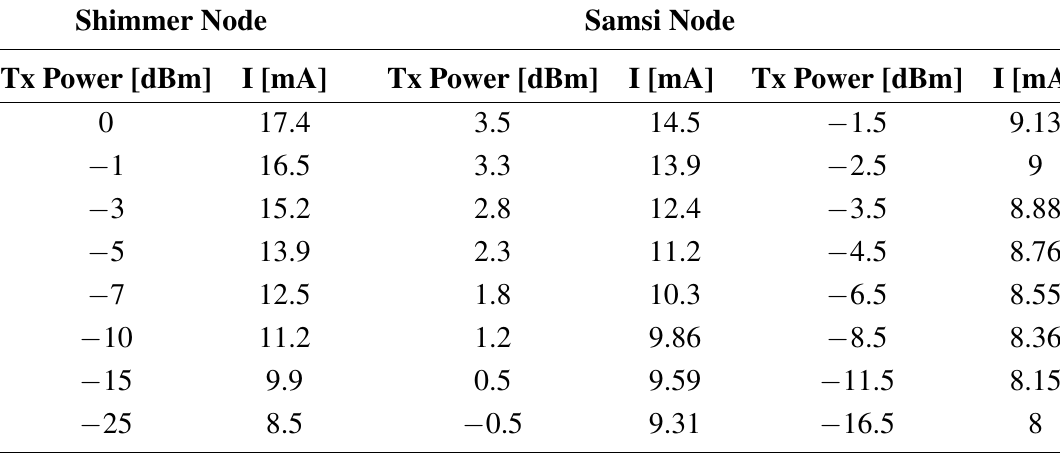
Table 1. Output power settings and typical current